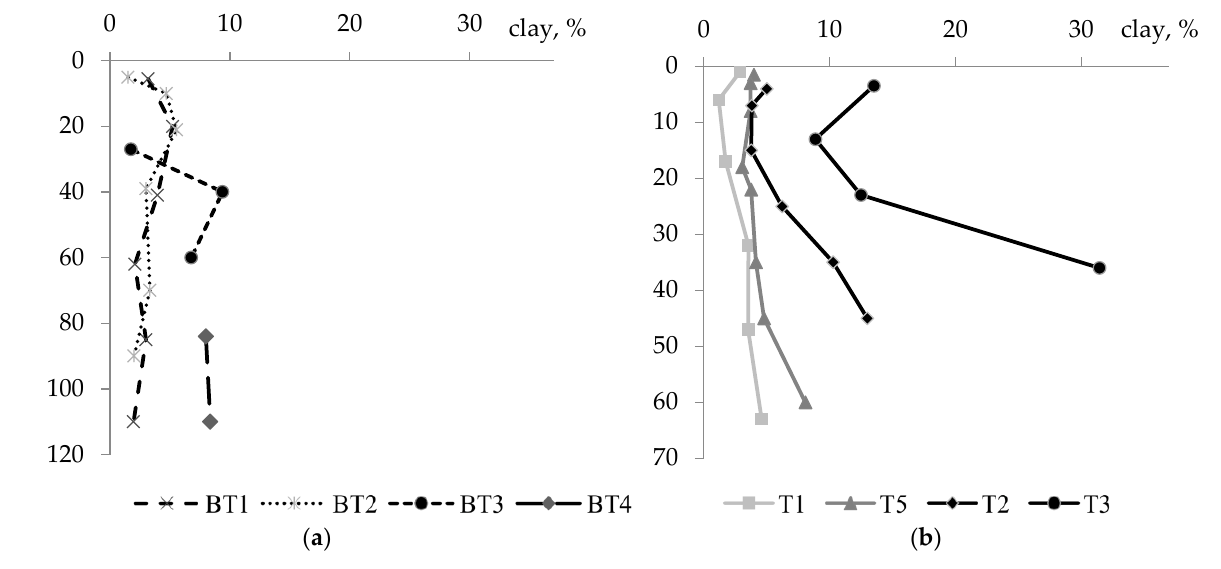
Figure 2. Distribution of clay particles in background soils ( a ), and soils formed on the quarry’s territory ( b ), along with the hydromorphism increase. Abbreviations on Figures 1 – 4 are the same. All abbreviations are explained at Table